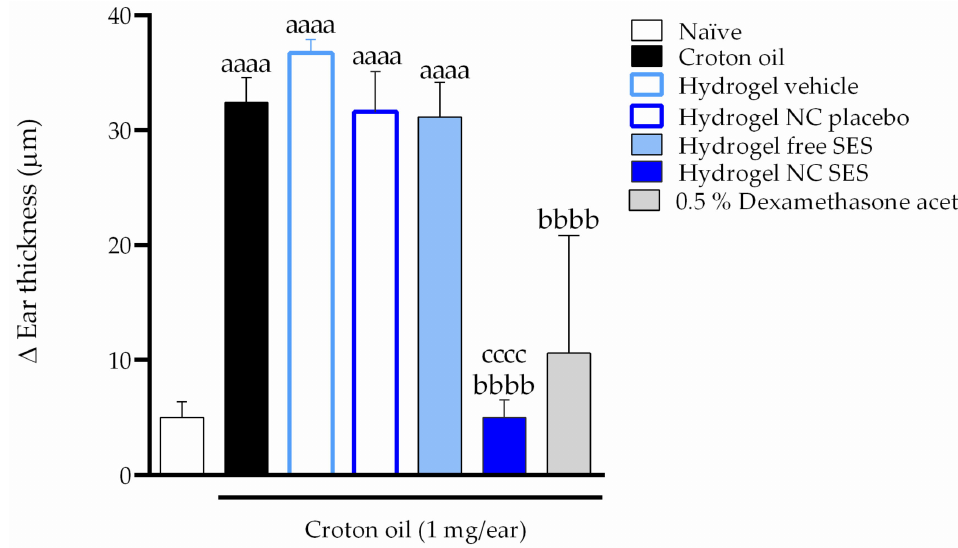
Figure 10. In vivo antiedematogenic effect of the hydrogels containing sesamol topically applied (15 mg/ear) in the croton-oil-induced ear edema model in Swiss mice. Immediately after the croton oil application, the mice’s ear received the treatments. Six hours after croton oil or croton oil plus treatments, the mice’s ear thickness was verified. Each bar represents the mean ± SEM ( n = 7); aaaa p < 0.0001 shows a significant difference when compared to the naïve group; bbbb p < 0.0001 shows a significant difference when compared to the croton oil control group; cccc p < 0.0001 shows a significant difference when compared to the Hydrogel free SES group. One-way ANOVA followed by post hoc Tukey’s